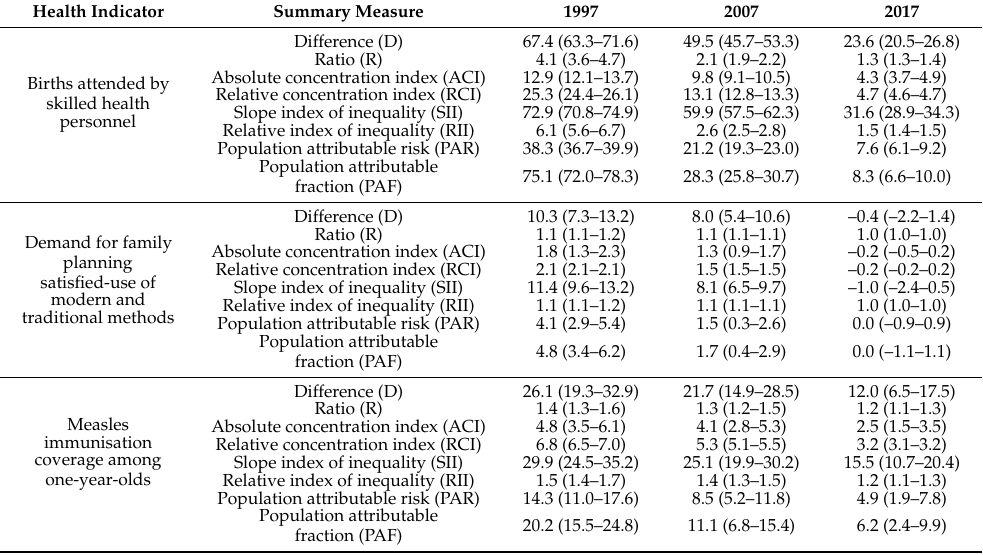
Table A7. Economic-related inequality in three reproductive, maternal and child health indicators: Indonesia (DHS: 1997, 2007 and 2017). Health Indicator Summary